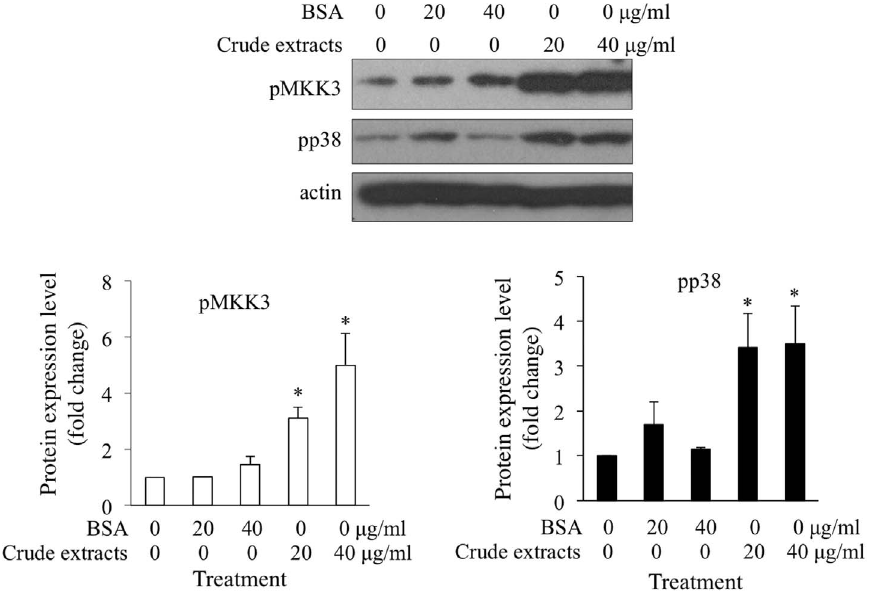
Figure 8. Treatment with adult barnacle crude extract significantly activated MKK3 and p38MAPK. Freshly transformed cyprids were treated with 20 or 40 m g/ml adult barnacle extract for 10 hours. The same concentration of BSA was used as protein control and cyprids without treatment were used as blank control. The relative levels of pp38MAPK and pMKK3 were determined by Western blot. Phosphorylation levels of MKK3 and p38MAPK in blank control were assigned unit of 1 and used for normalization. Multiple comparison analysis showed that both 20 and 40 m g/ml of adult barnacle extract significantly induced the activation of p38MAPK and MKK3, but the same concentration of BSA did not have any effects. The asterisks indicate significant differences from the blank